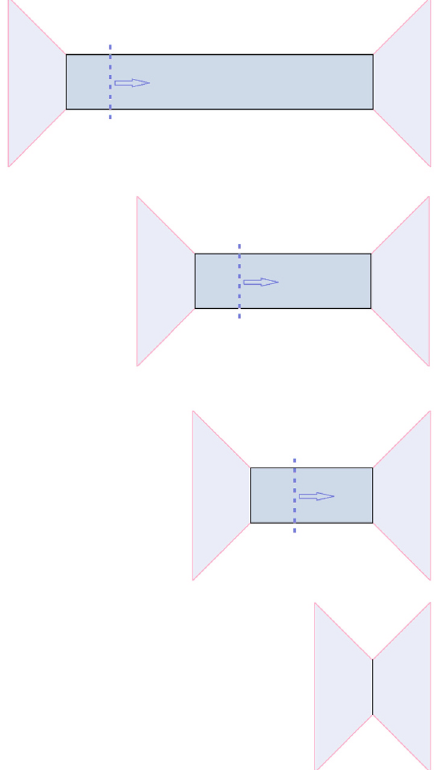
Figure 2 . Successive spatial slices through the wormhole. Since the two sides are maximally entangled, Alice is able to shorten the wormhole by unitary operations U A her